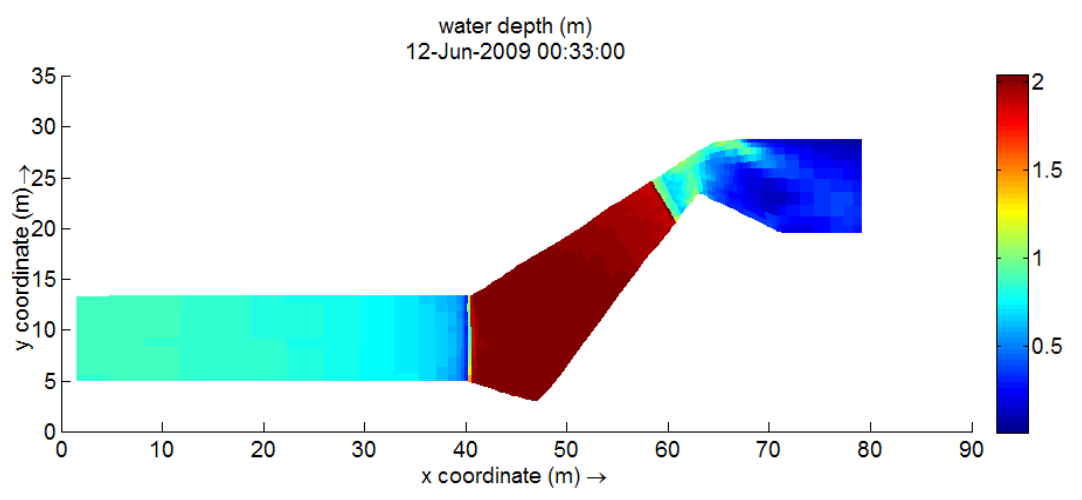
Figure 11. Depth variation in the flow system for HDS scenario (see Table 1).